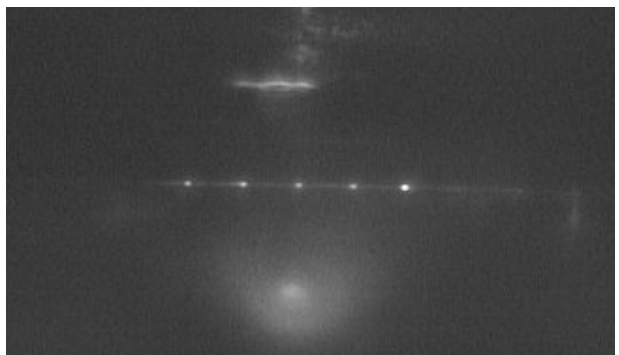
Figure 6. Near-field guided-mode patterns of the AWG.